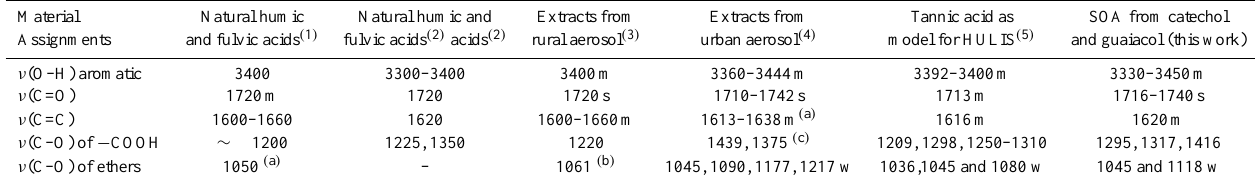
Table 2. Comparison of the band positions [cm − 1 ] and strengths (w = weak, m = medium, s = strong) of the present ATR-FTIR spectra of SOA from catechol and guaiacol with IR spectra of natural humic and fulvic acids and HULIS and other HULIS